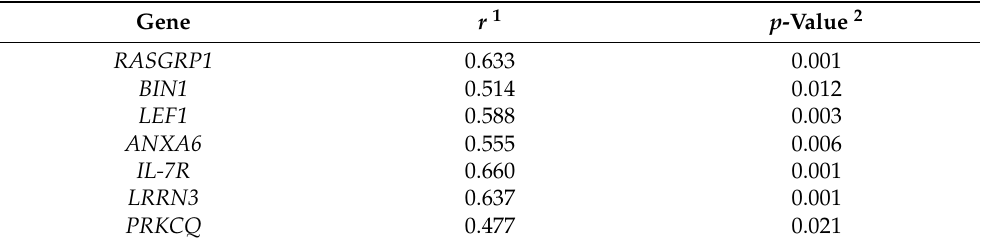
Table 4. Correlation analysis between gene expression and leg extension in combined group.